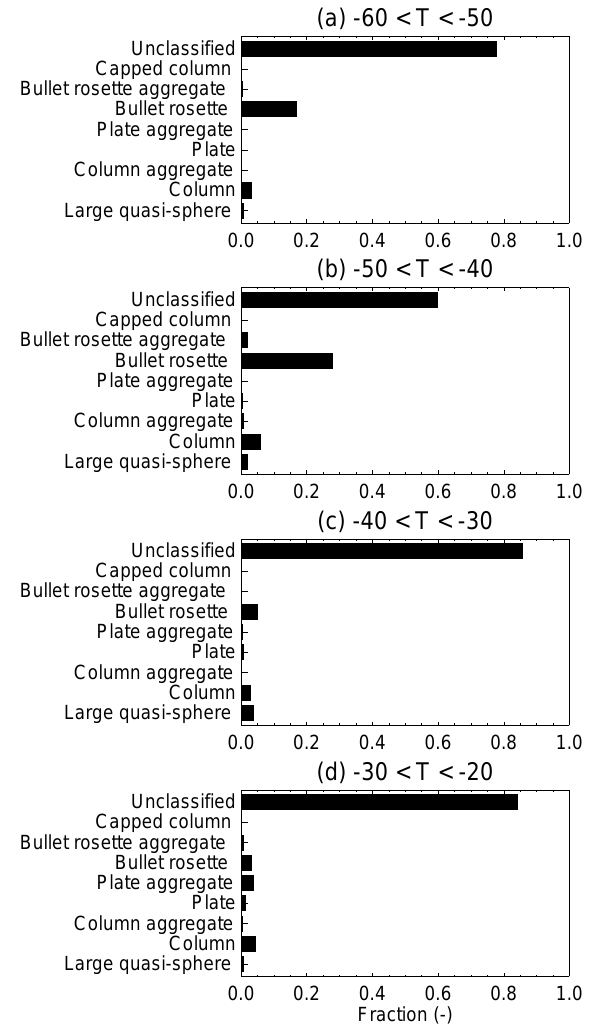
Figure 8. Fraction of imaged ice crystals with D max greater than 100µm in four temperature ranges in degrees